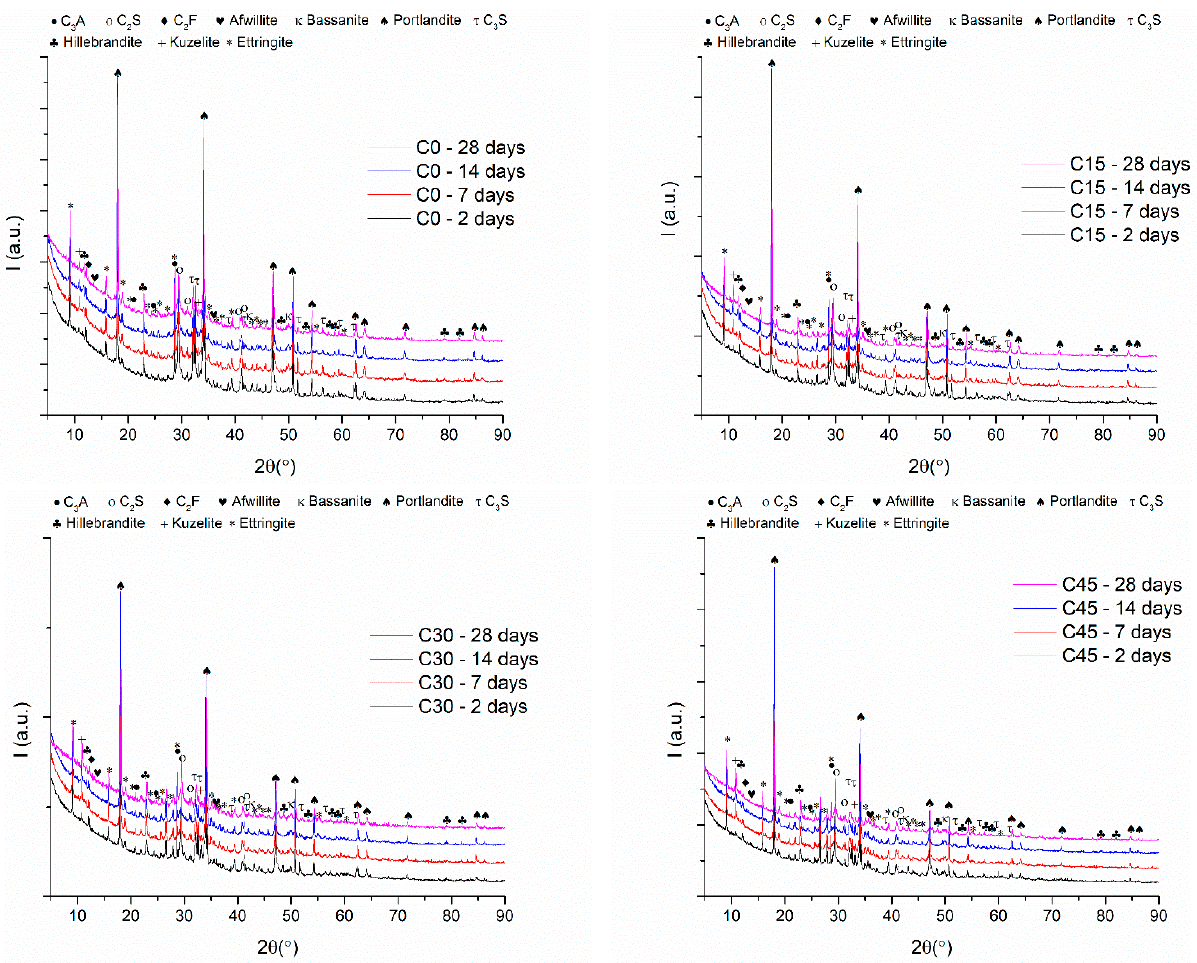
Figure 7. Sample viscosity after 5 min.